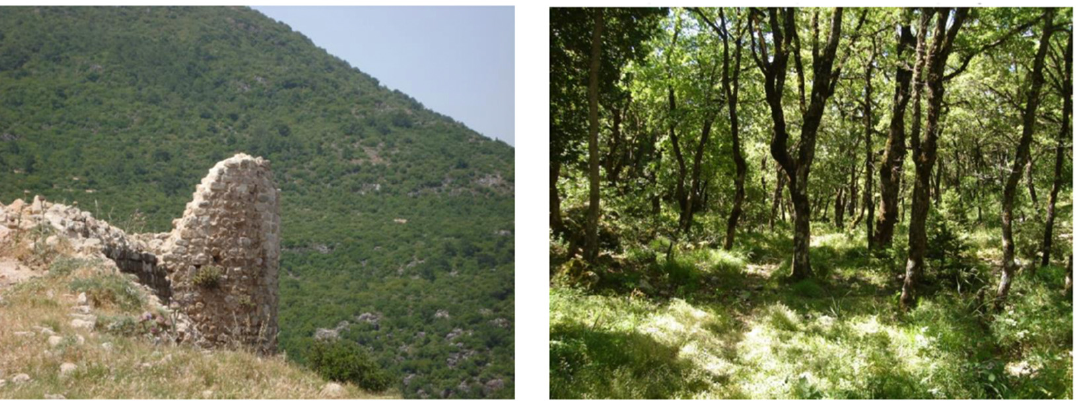
Figure 10. The different environmental zones in “Abu Qubies—Mshta Elbeer” tourism hiking trails in Abu Qubies. Source: author, 2021.